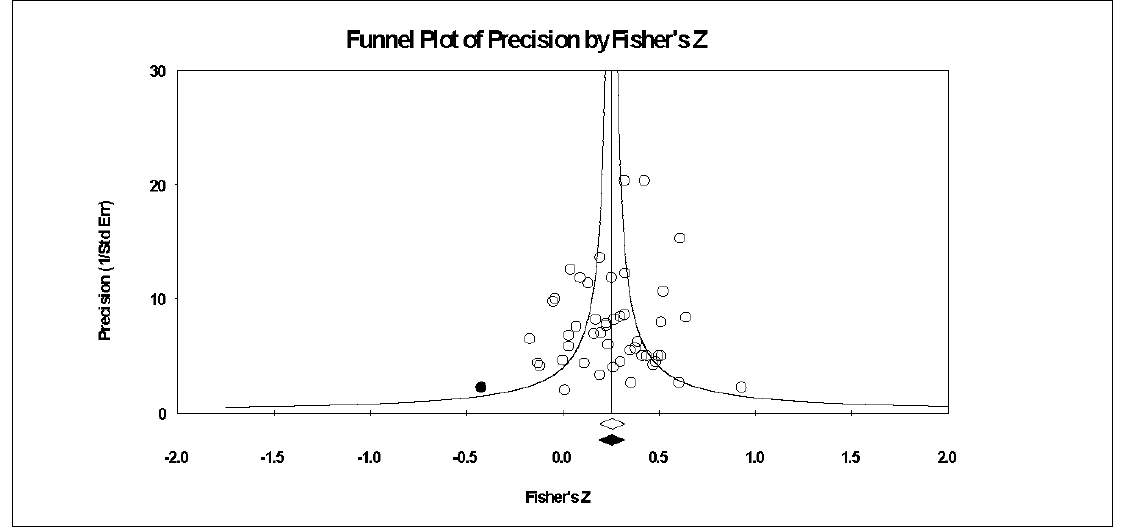
Figure 3. Random effects plot trimmed and filled. The open circles are the data points, and the one filled circle is the result of the trim and fill analysis. The clear rhombus is the point estimate, and the filled rhombus is the trim and filled point estimate.